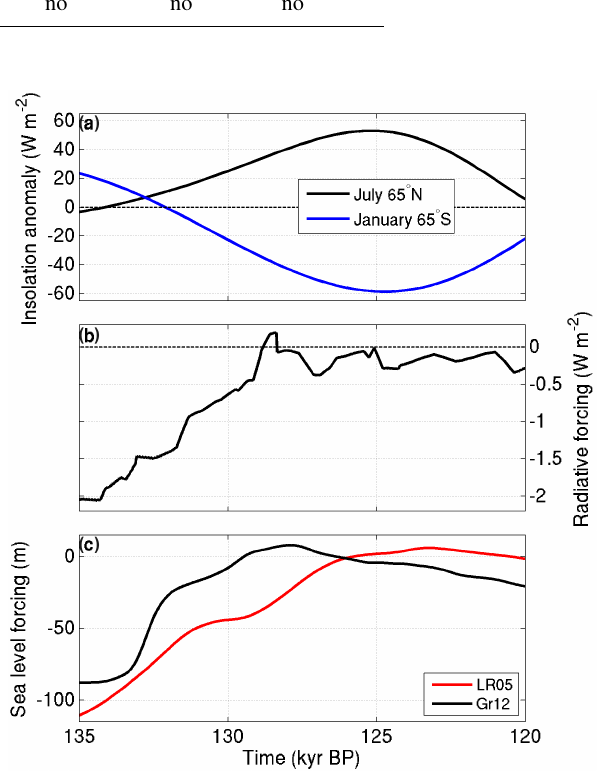
Figure 4. Prescribed model forcings. (a) Average monthly inso- lation anomaly relative to the pre-industrial era at 65 ◦ N in July (black) and 65 ◦ S in January (blue). (b) Combined radiative forc- ing anomaly of prescribed greenhouse gas concentrations (CO 2 , CH 4 , N 2 O) relative to the pre-industrial era. (c) Sea-level forcing for the ice sheet components derived from either oceanic δ 18 O data (Lisiecki and Raymo, 2005, red) scaled to a global sea-level con- trast between LGM and present day of 130m or from a Red Sea relative sea-level record (Grant et al., 2012, black).